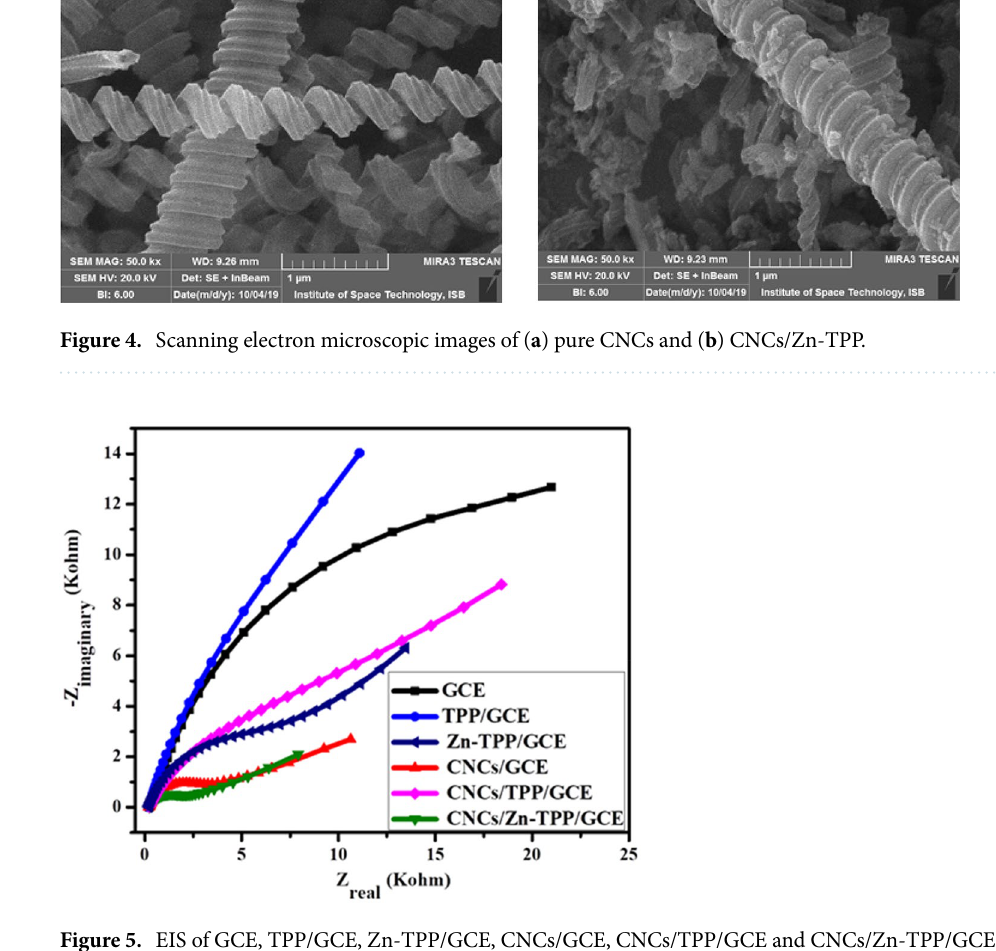
Figure 5. EIS of GCE, TPP/GCE, Zn-TPP/GCE, CNCs/GCE, CNCs/TPP/GCE and CNCs/Zn-TPP/GCE in 0.5 mM K 3 [Fe (CN) 6 ] and 0.1 M